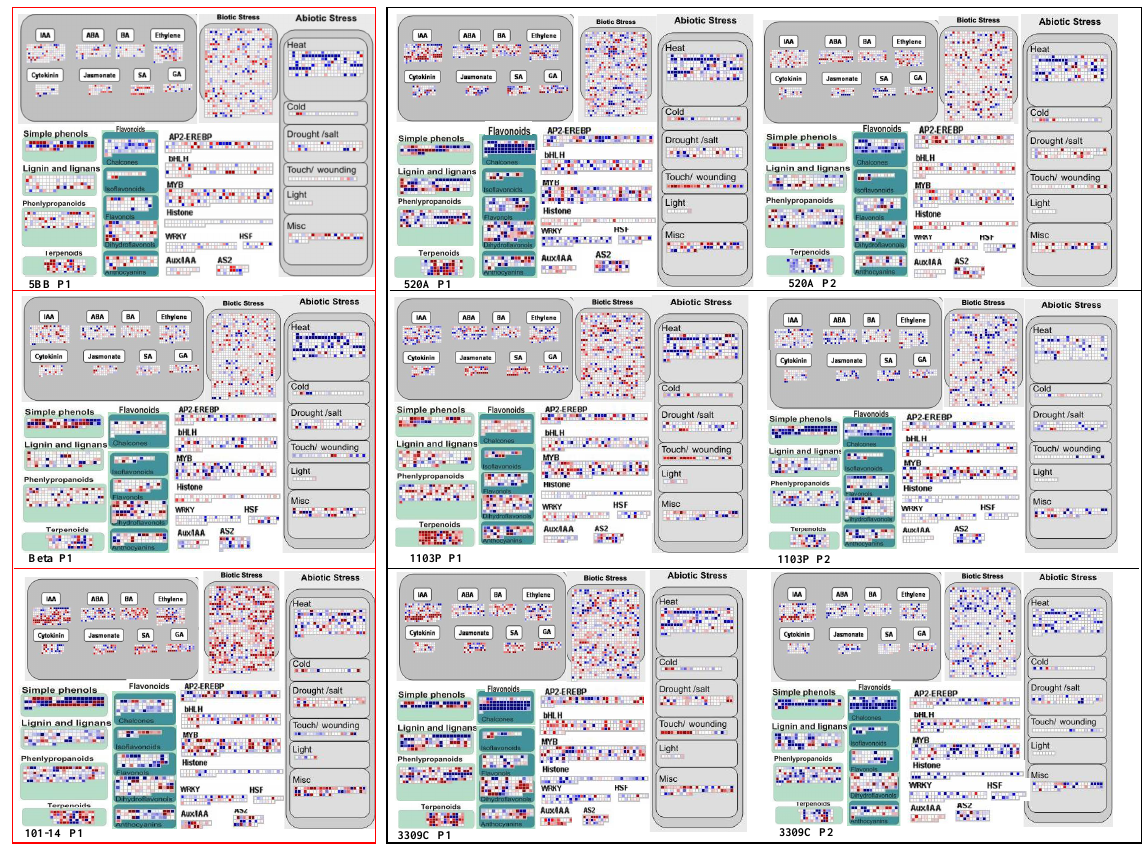
Figure 5. DEGs assigned to the main metabolic process, according to Mapman software. This map consists of the genes that participated in hormone-related genes, abiotic stress, biotic stress, transcription factors, and the secondary metabolism genes including implicated flavonoids, simple phenols, lignin and lignans, phenlypropanoids, and terpenoids. Blue represents upregulation; red represents